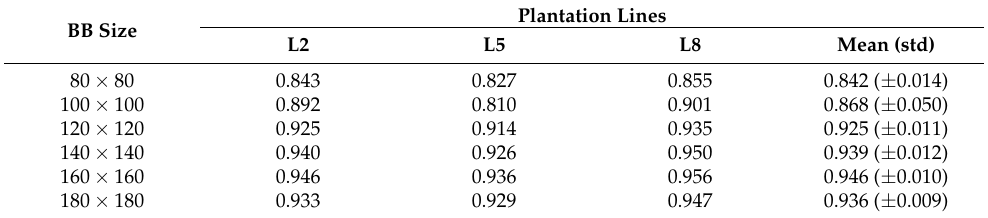
Table 5. Results of Average Precision for different bounding box (BB) sizes obtained by the ATSS.